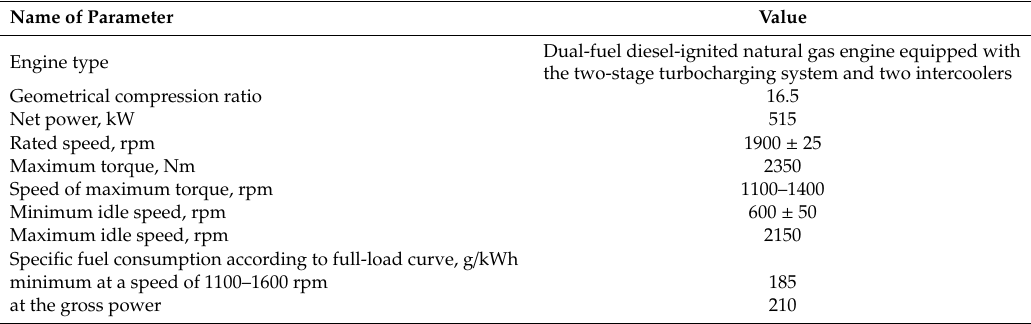
Table 1. Main characteristics of the engine under